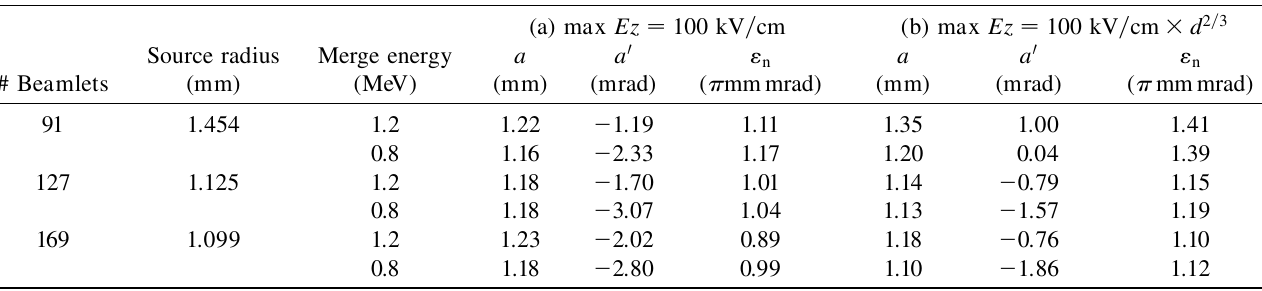
TABLE II. Optimized aperture columns. Two cases were examined, with differing limits on the voltage gradients. In the first case (a), the gradient is independent of the plate separation. In the second case (b), the gradient depends on the plate separation, d , given here in centimeters.